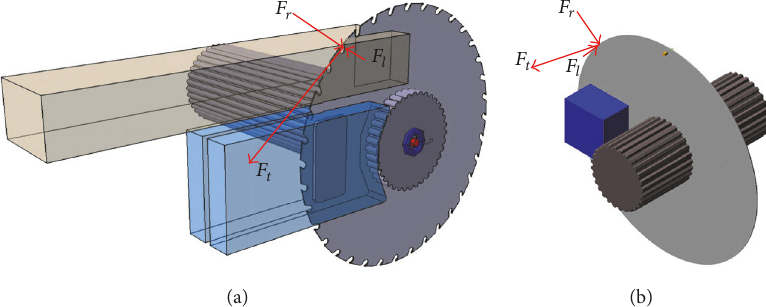
Figure 3: Schematic of the computer model with the components of cutting forces, 𝐹 𝑟 , 𝐹 𝑡 , and 𝐹 𝑙 are radial, tangential, and lateral components of the force (b). The component of cutting forces on a teeth